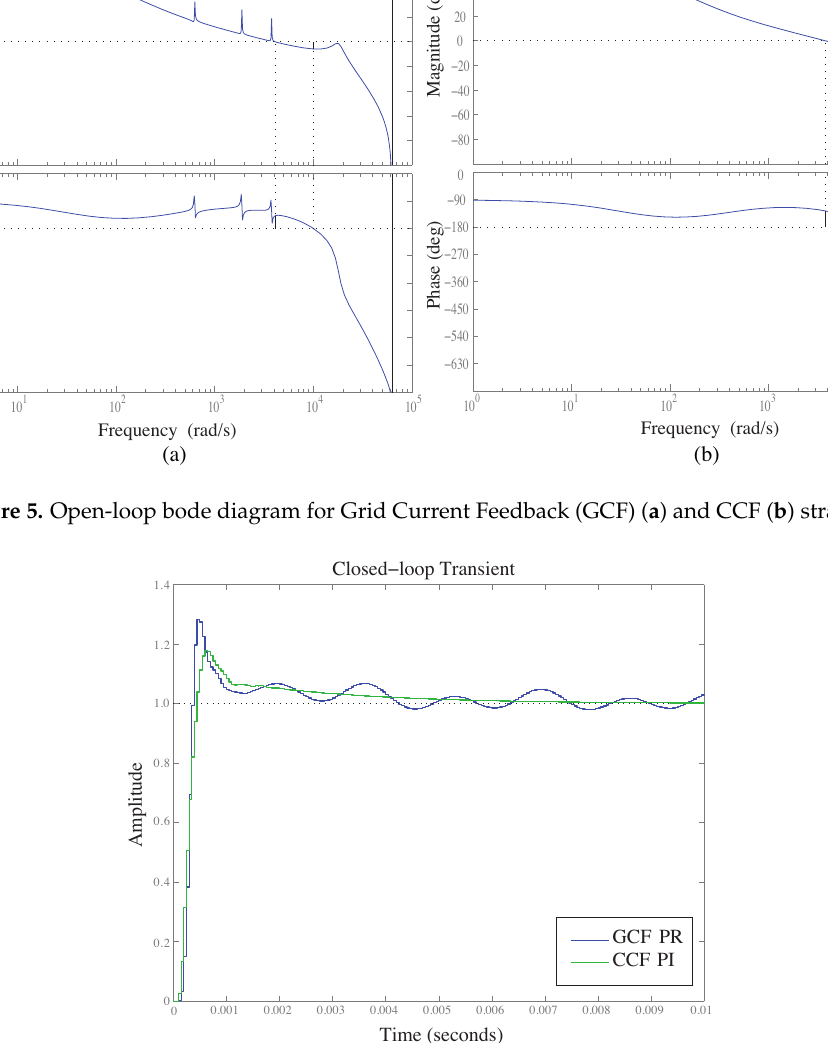
Figure 6. Step response for the GCF and CCF strategy. PR,